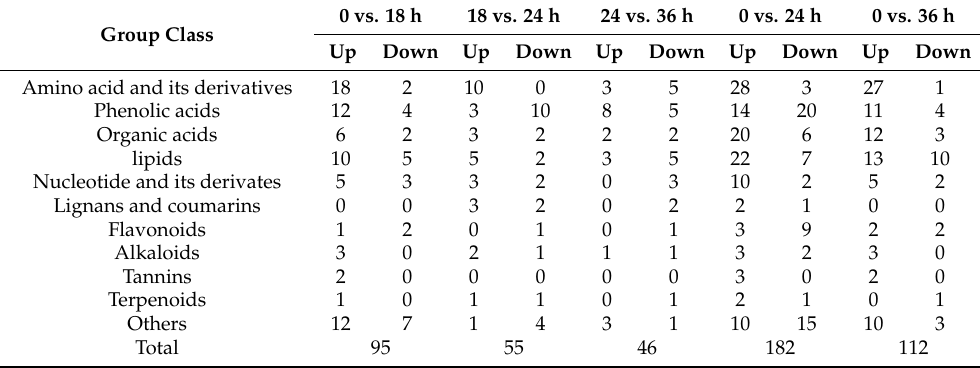
Table 1. Number of differential metabolites in the leaves of Jerusalem artichoke with drought stress. 0 vs. 18 h Group Class Amino acid and its